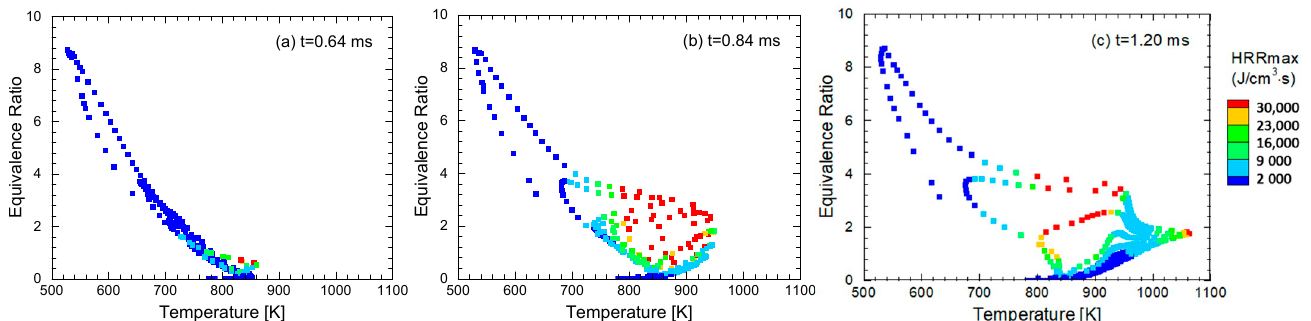
Figure 2. Φ -T diagram of the HRR in CVB with the mechanism of Wang et al. [39] (ambient gas initial temperature 850 K, ambient gas oxygen concentration 21%, gas density 14.8 kg/m 3 ).